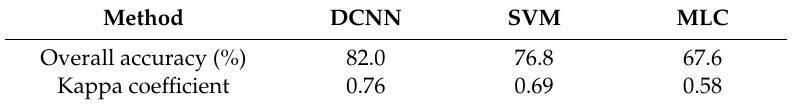
Table 2. Comparison of the accuracies of the results of the DCNN, SVM and MLC methods.